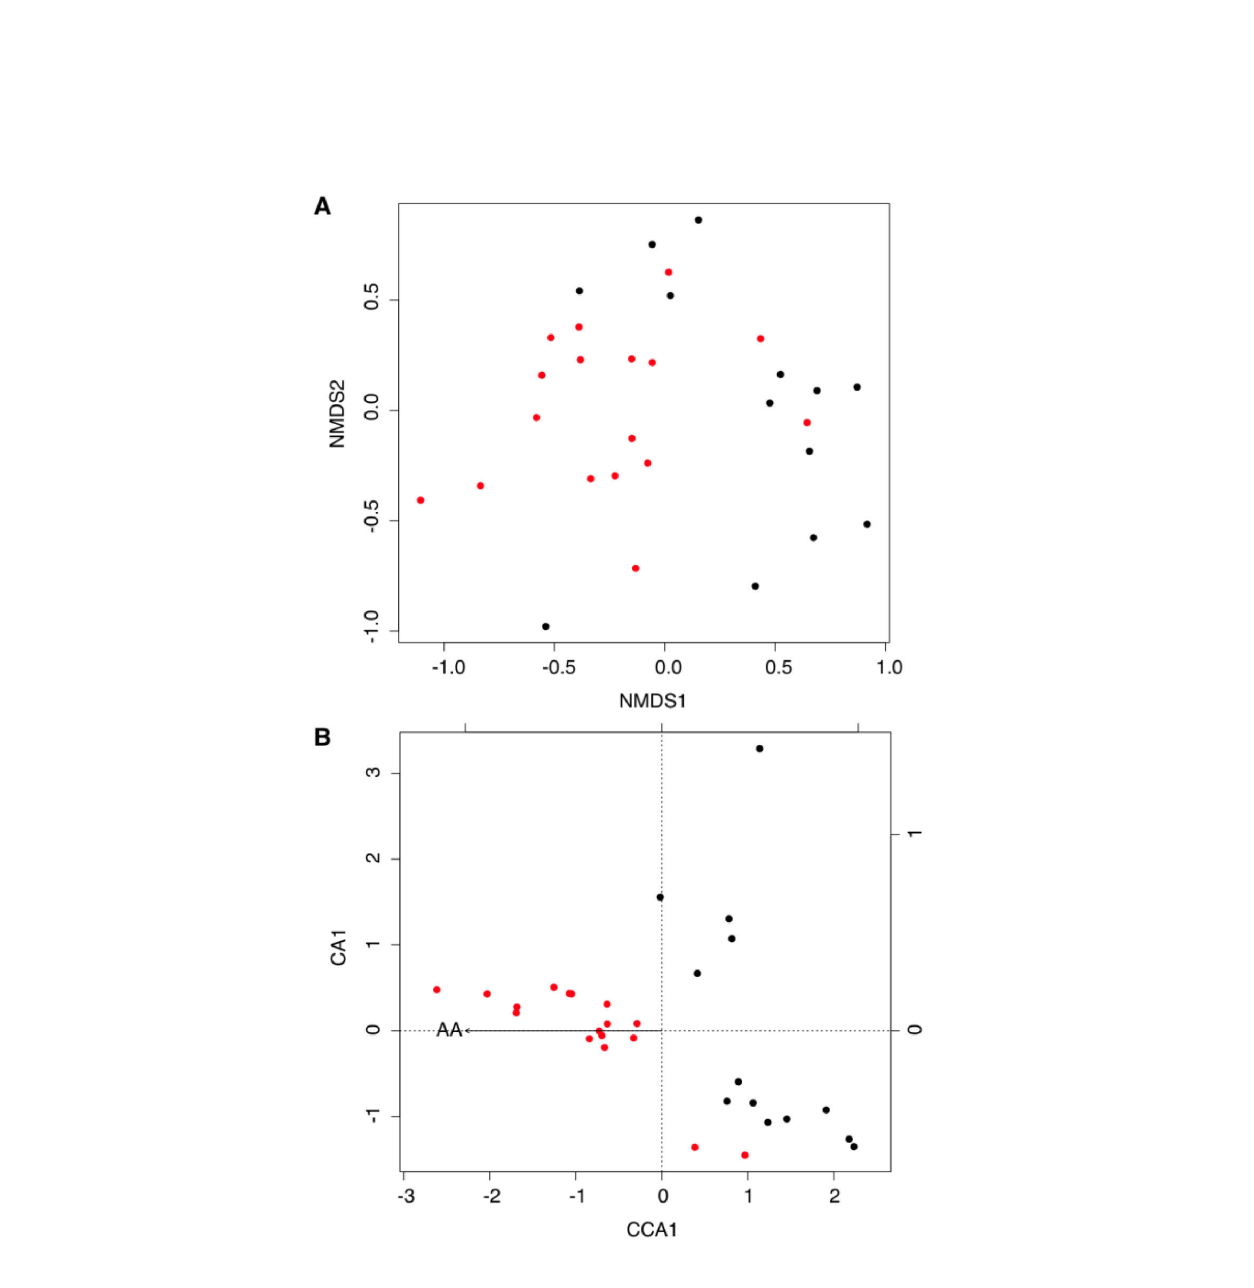
Figure 2. Effect of Aa and microbial community composition, as measured by HOMIM hybridization scores. The following variables were chosen as descriptors of the subgingival biofilm community and were calculated for each sample: pocket depth (PD), and presence of Aa . This last term was chosen to determine if Aa alone reflects shifts in community composition. A. Non-metric multidimensional scaling analysis (NMDS) and B. Canonical correspondence analysis (CCA) ordination diagrams of microbial communities. Red circles indicate samples where Aa was detected by HOMIM, and black circles indicate samples where there was no Aa detected by HOMIM analysis. Aa was critical for determining bacterial community structures (p<0.01). doi: 10.1371/journal.pone.0085066.g002 presence or absence of Aa was associated with a difference in We also evaluated the correlation between the detection of the composition of the microbial community as a whole. Aa and local inflammatory mediators as a measure of active disease. Interestingly, a higher expression of IL-8 in GCF was